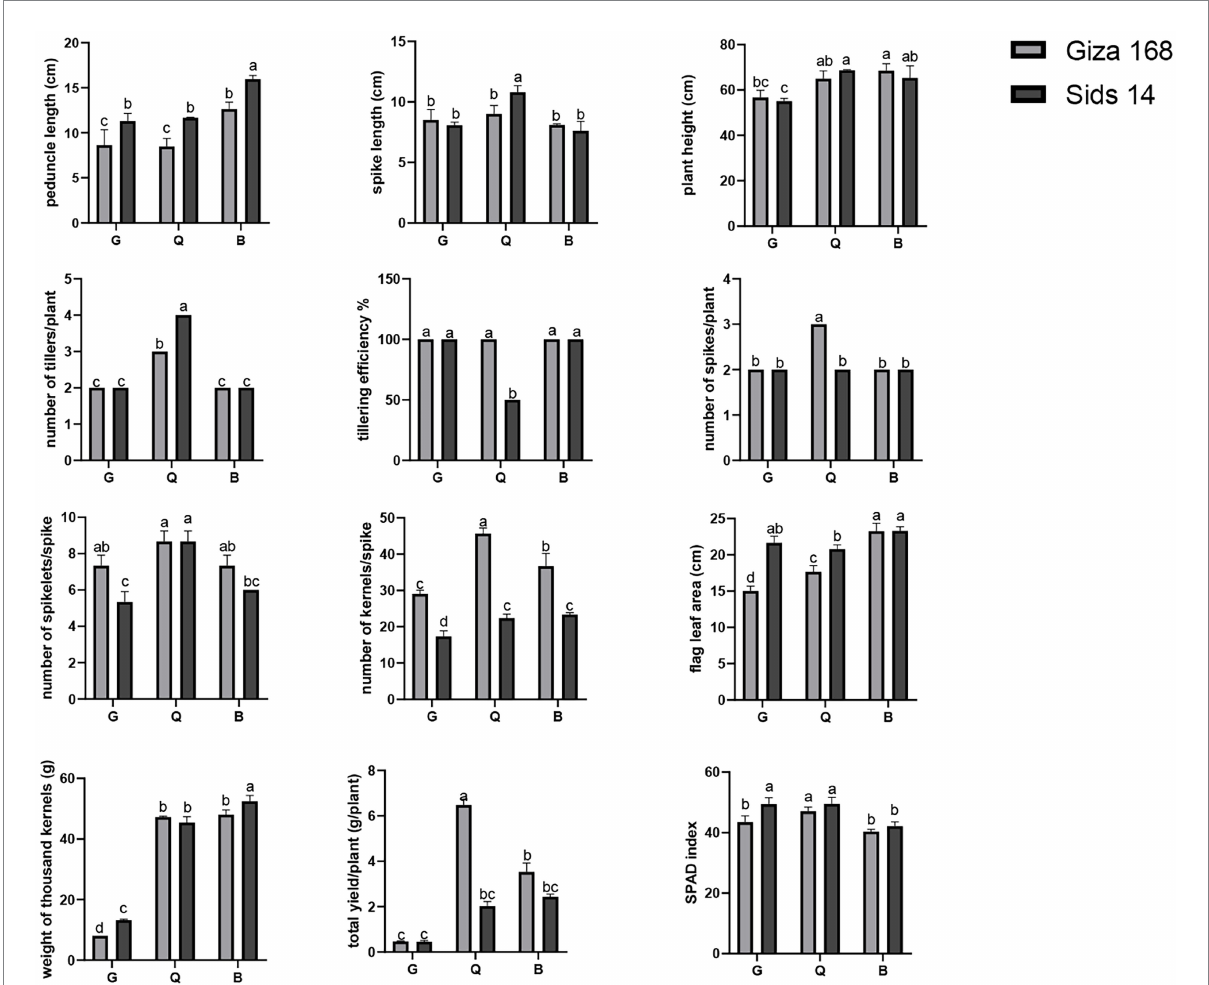
FIGURE 5 The growth characteristics of two cultivars of wheat (Giza 168, and Sids 14) grown under various soil types. Tukey’s Multiple Comparisons Test was conducted to ascertain the significant difference between means at a significant level of p < 0.05 and represented as mean ± standard deviation (SD). Different letters indicate significant differences ( p ≤ 0.05) between the samples ( n = 3). G; Giza location, Q; Al-Qalyubia location, and B; Beni-Suef